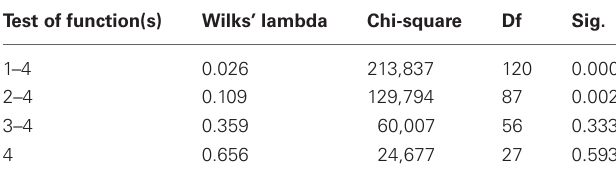
Table 2 | Predicted group membership based on 30 variables. Table 3 | Wilks’s lambda test.